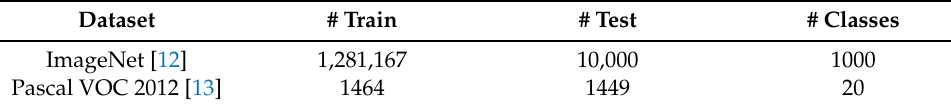
Table 2. The summary of datasets used in the